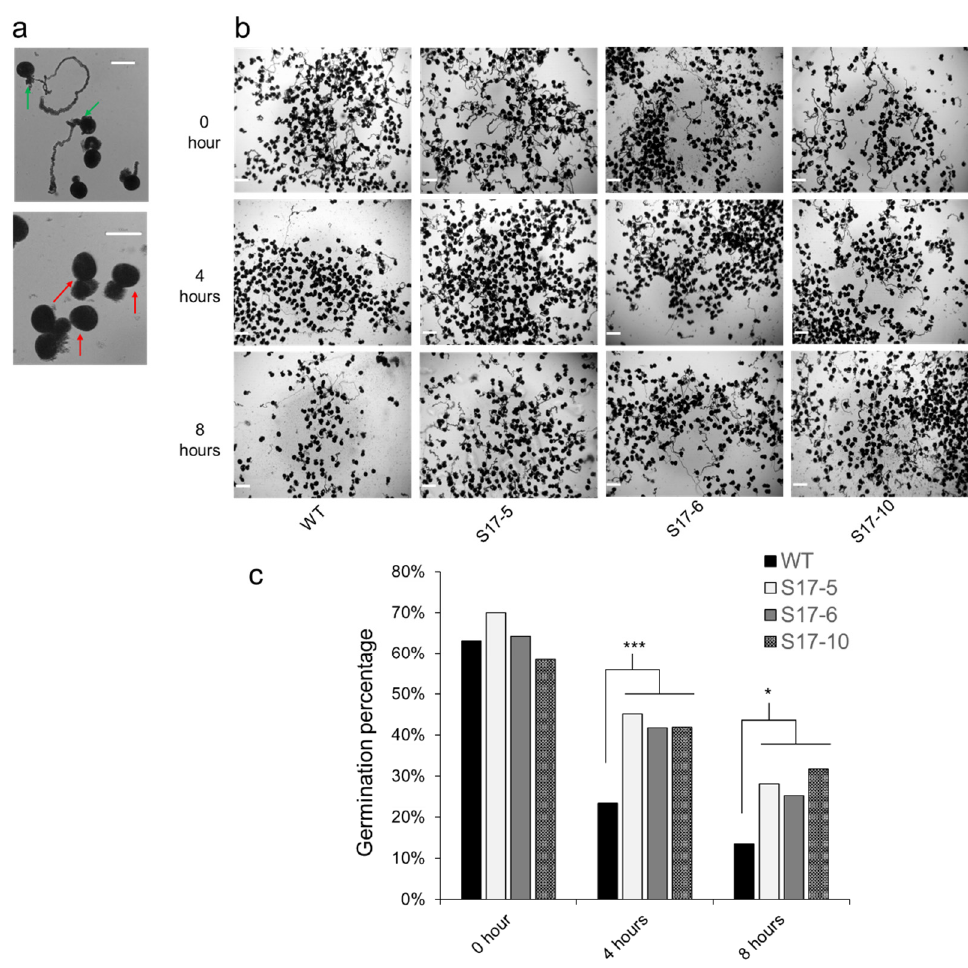
Figure 2. Pollen germination of the AtGRXS17 -expressing and WT maize under drought stress. ( a ) Pollen germination (Upper panel; green arrow) and pollen that failed to germinate (Lower panel; red arrow) in the pollen germination media; ( b ) Time course germination rate of pollen kept at room temperature; ( c ) Pollen germination rate at 0, 4, and 8 h timepoint of the WT and AtGRXS17 - expressing maize plants. Scale bars = 100 µ m. Data shown are Mean ± SE ( n = 3) and were analyzed using one-way ANOVA. Asterisks indicate significance level (* p < 0.05, *** p < 0.001).